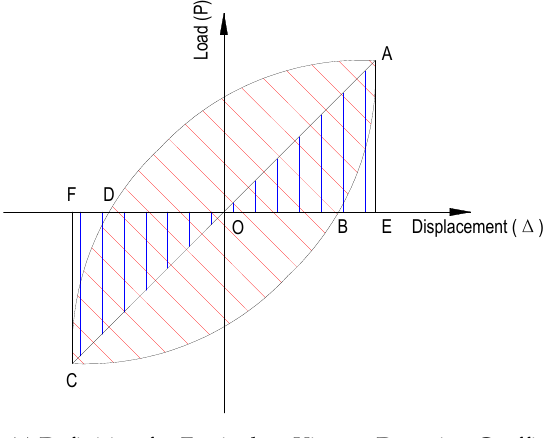
Figure 6. Analysis Methods for Experimental Observations ( a ) Hysteresis Curve and Skeleton Curve; ( b ) Yield Strength and Yield Displacement; and, ( c ) Equivalent Viscous Damping Coefficient.